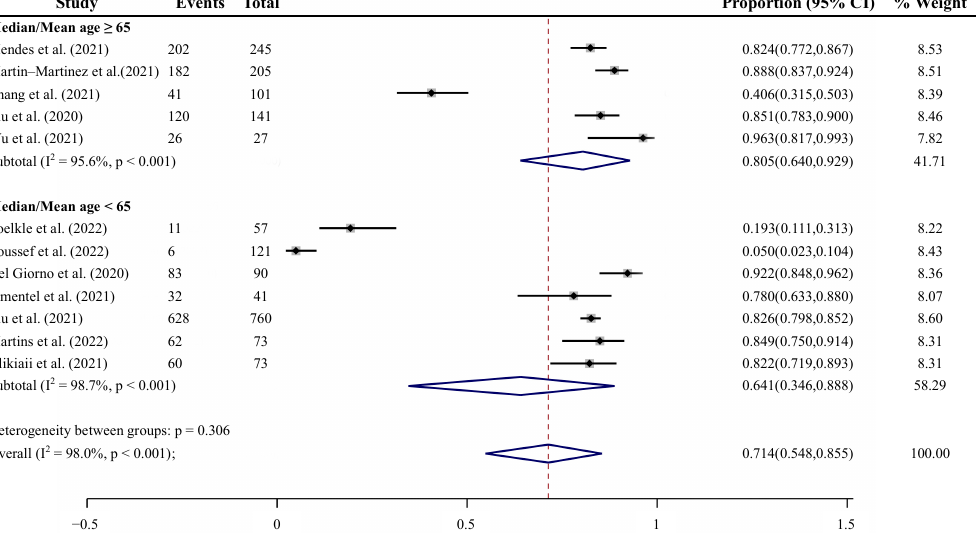
Figure 4. Subgroup analysis of the pooled prevalence of malnutrition in COVID-19 patients by medium/mean age [36,38–41,43–46,49,51,52]. According to the World Bank criteria for classifying countries by income level, the individual studies were stratified into three categories: high-income economies (Switzer- land, Spain, Italy, and Poland), upper-middle-income economies (China and Brazil), and lower-middle-income economies (Philippines, Egypt, and Iran). The pooled prevalence in the high-income economies, upper-middle-income economies, and lower-middle-income economies was 78.9% (95% CI: 65.0% to 90.0%), 81.5% (95% CI: 70.3% to 90.5%), and 73.6% (95% CI: 35.0% to 98.2%), respectively, indicating little difference between countries by income level ( p = 0.893) (Figure